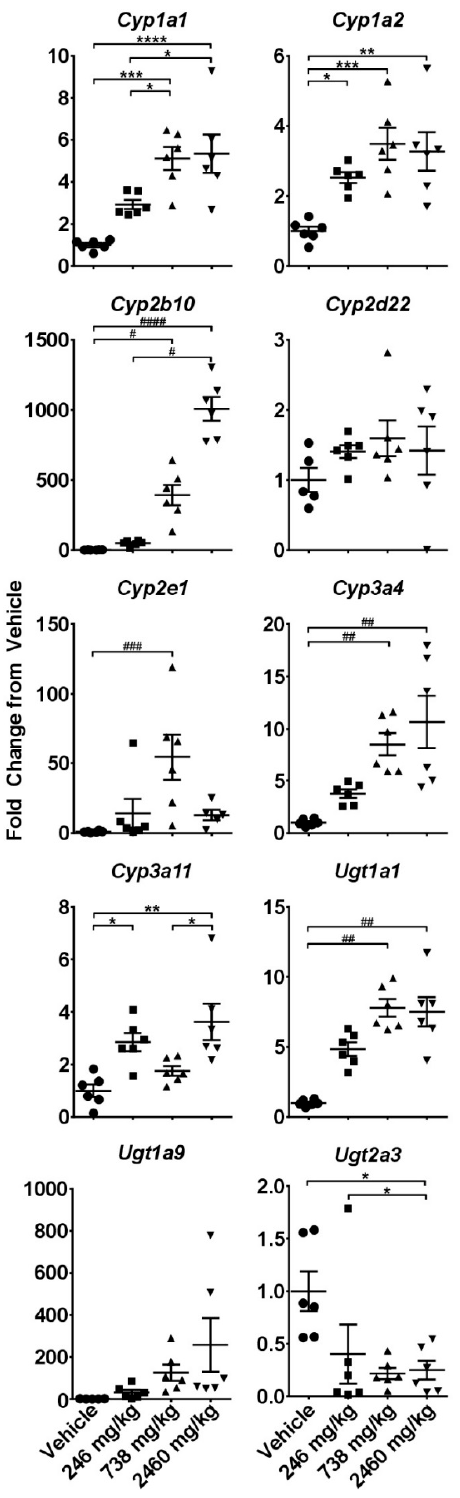
Figure 2. Effects of single gavage with CBD on intrahepatic expression of cytochrome P450s and UDP ‐ glucuronosyltransferases. Livers were collected at 24 h and gene expression was measured using the quantitative real ‐ time (qRT) PCR. * ‐ indicate data analyzed by One ‐ Way ANOVA with Tukey’s post ‐ test, and # indicate non ‐ normal data analyzed with a Kruskal ‐ Wallis and Dunn’s post ‐ hoc test. Data are presented as mean ± SEM fold changed from vehicle ( n = 6), with * or # as p < 0.05; ** or ## as p < 0.01; *** or ### as p < 0.001; and **** or #### as p < 0.0001.